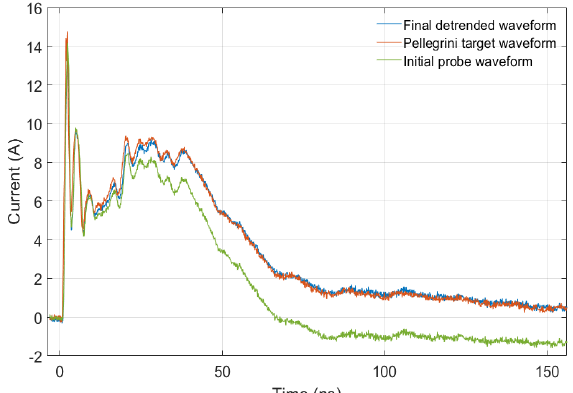
Figure 9. Comparison of the Pellegrini target (reference) waveform, the initial current probe acquired waveform, and the final detrended (reconstructed) waveform for a +4 kV pulse with the EM Test Dito generator.